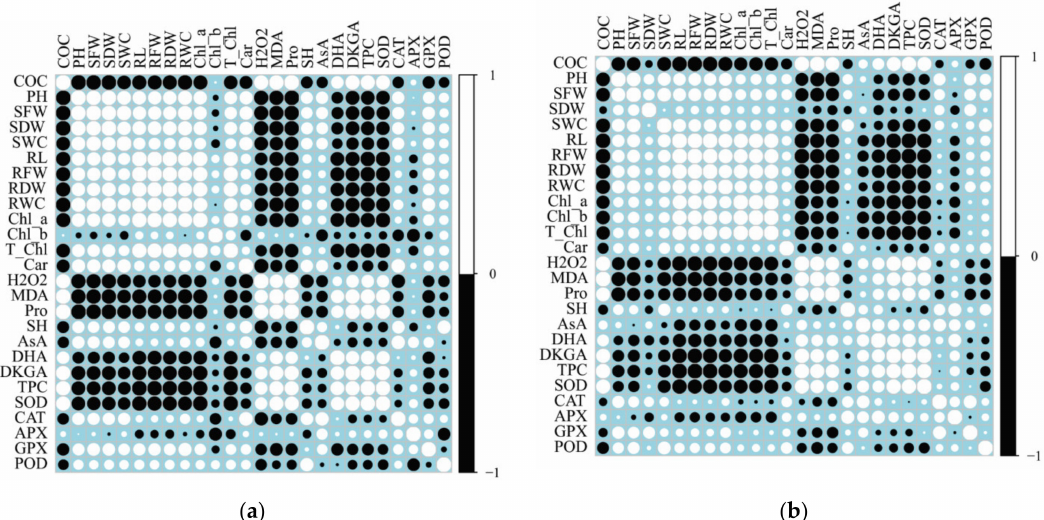
Figure 5. Pearson correlation plots for the studied growth parameters (COC—crude oil concentration in soil, PH—plant